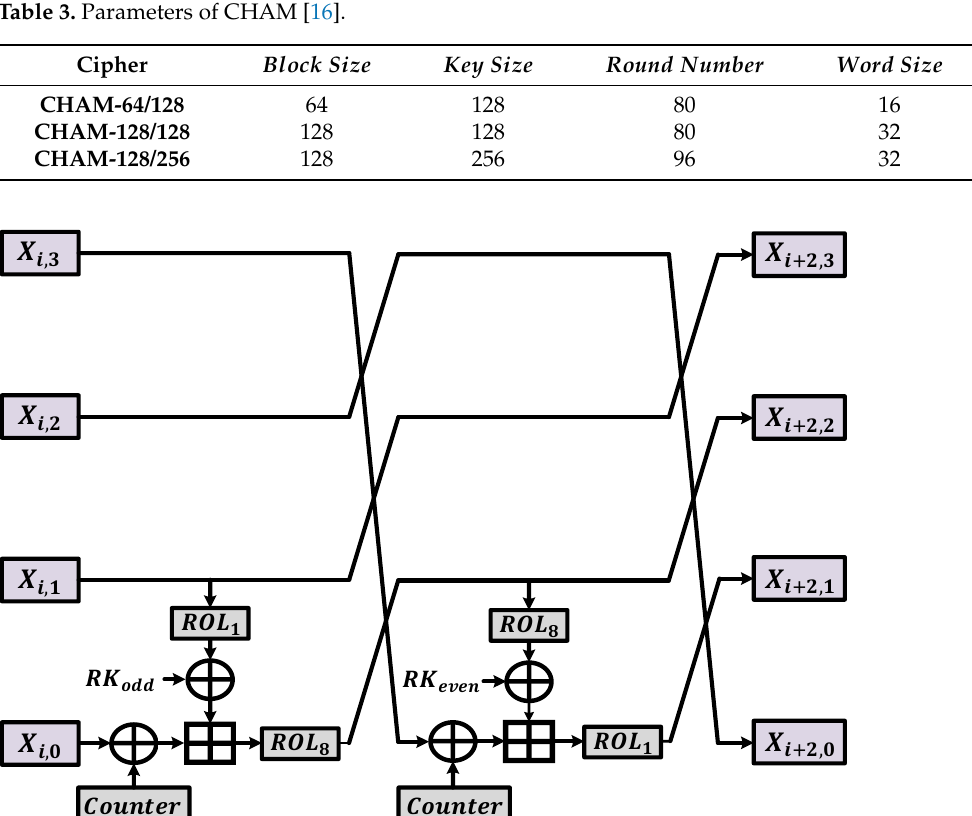
Figure 4. CHAM round functions [16] ( RK odd : RK imod 2 k / w , RK even : RK i + 1 mod 2 k / w , ROL 8 and ROL 1 : rotate